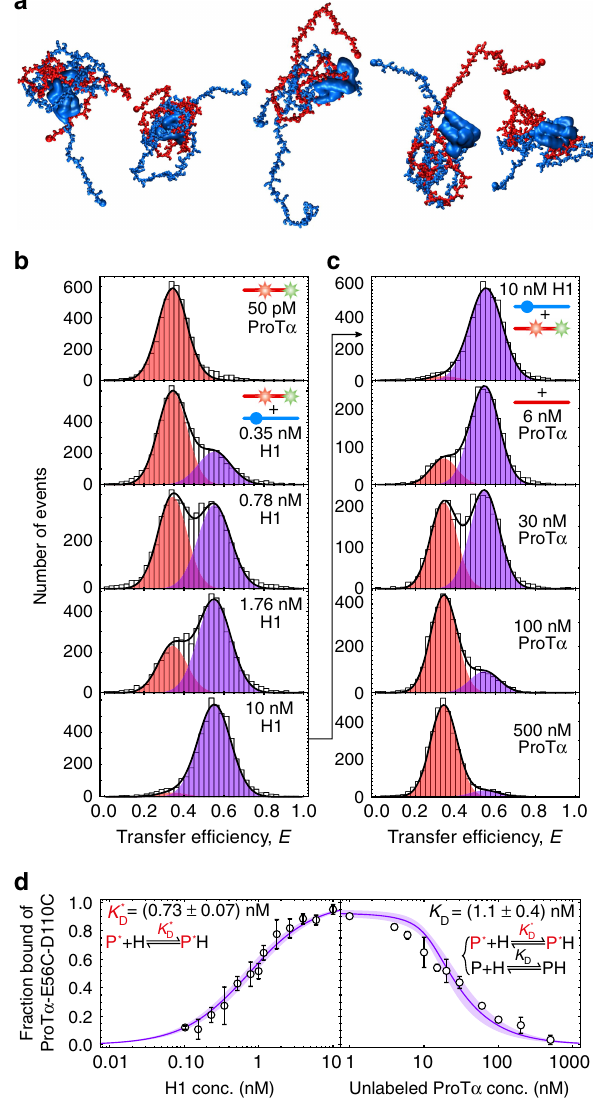
Fig. 1 High-af fi nity binding of H1 to ProT α is independent of fl uorescence labeling. a Illustration of the highly dynamic and intrinsically disordered protein complex between ProT α (red) and H1 (blue) with snapshots from coarse-grained MD simulations 12 . b Transfer ef fi ciency histograms of 50 pM ProT α E56C/D110C labeled with Alexa Fluor 488/594 in the presence of increasing concentrations of unlabeled H1 at 200 mM ionic strength, fi t globally with two Gaussian peak functions for the unbound (red) and bound (purple) ProT α populations, respectively (sum: black lines). c Transfer ef fi ciency histograms from a competition experiment with constant concentrations of 50 pM labeled ProT α and 10 nM unlabeled H1, and increasing concentration of unlabeled ProT α as indicated in the panels. d Resulting fractions of bound labeled ProT α as a function of the total concentration of H1 (left panel, b ) and unlabeled ProT α (right panel, c ). The global fi t of the two datasets (continuous line, see “ Methods ” for details) results in an af fi nity of H1 for fl uorophore-labeled ProT α of (0.73 ± 0.07) nM and for unlabeled ProT α of (1.1 ± 0.4) nM (s.d. calculated from at least three independent